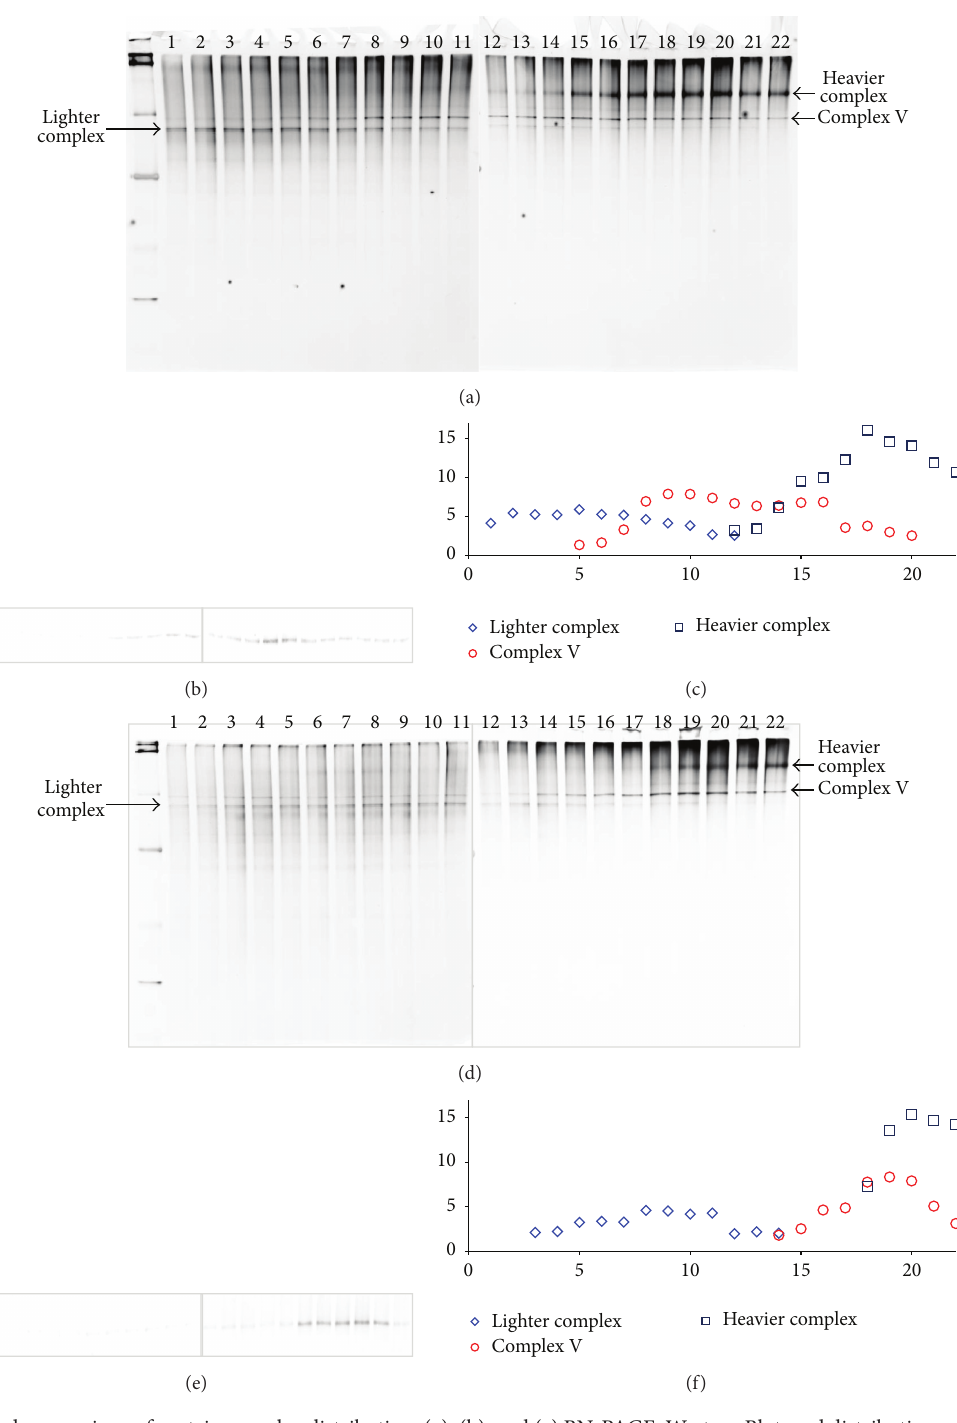
Figure 3: Detailed comparison of protein complex distribution. (a), (b), and (c) BN-PAGE, Western Blot, and distribution profile of samples prepared by conventional aspiration method. (d), (e), and (f) BN-PAGE, Western Blot, and distribution profile of samples prepared by F-S